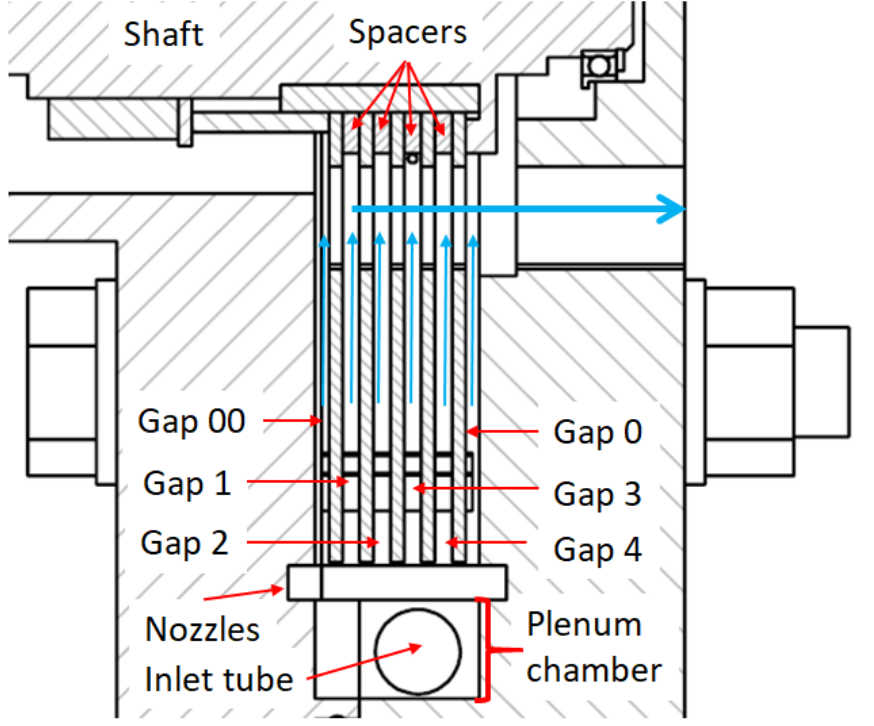
Figure 1. Internal flow system of the turbine (blue arrows–flow direction).